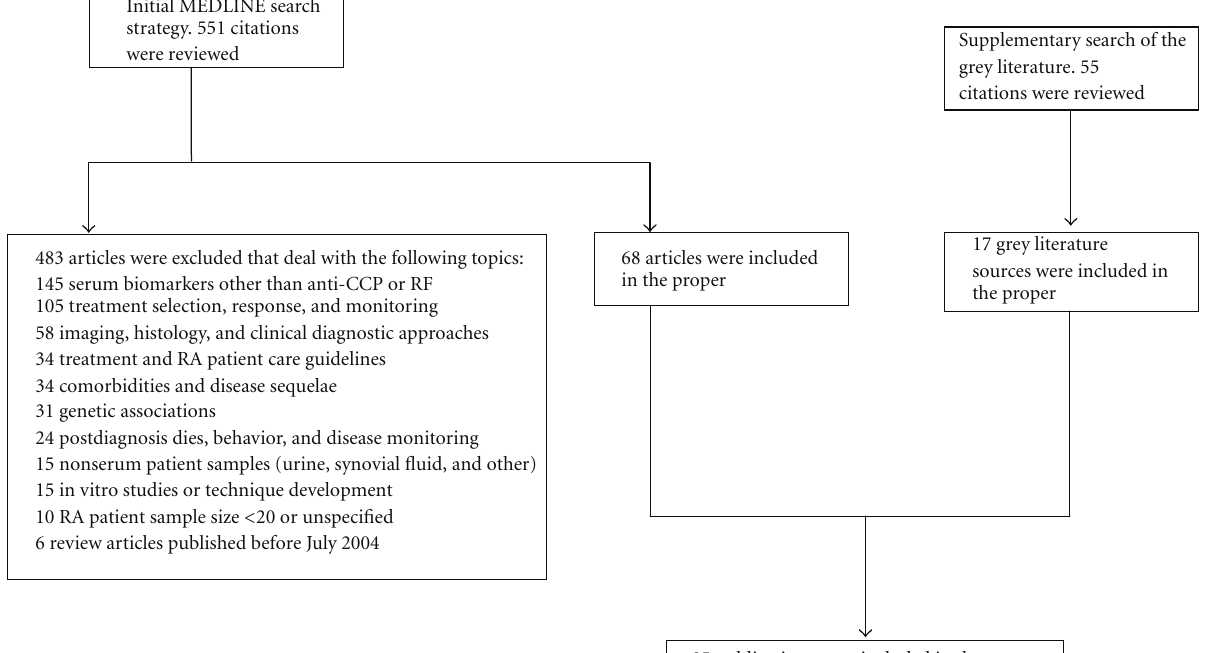
Figure 2: Literature retrieval